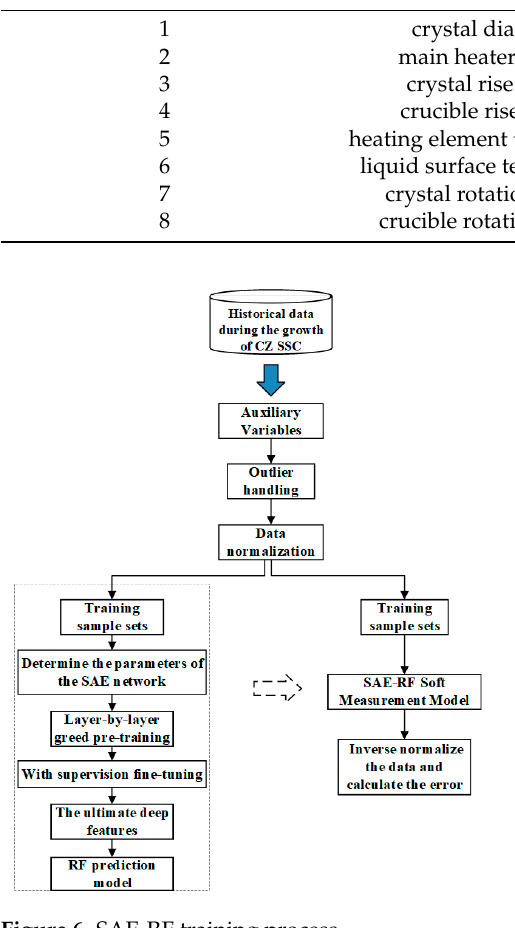
Figure 6. SAE-RF training process.